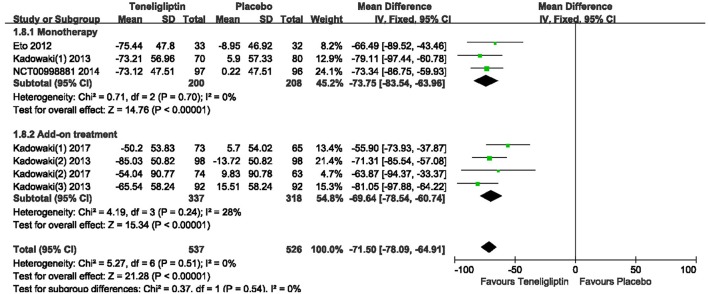
Meta-analysis for Effects of teneligliptin and placebo on AUC0−2h for PPG change from the baseline by meta-analysis.